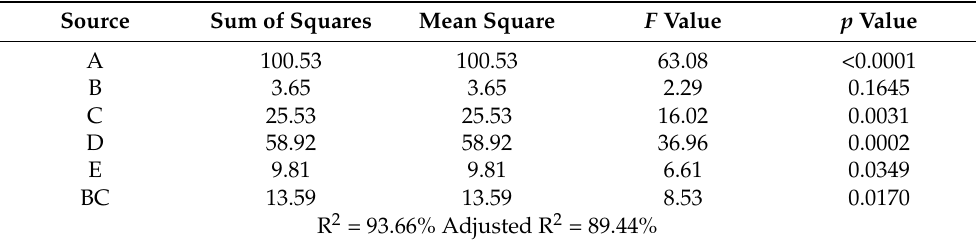
Table 6. ANOVA analysis of the cell adhesion